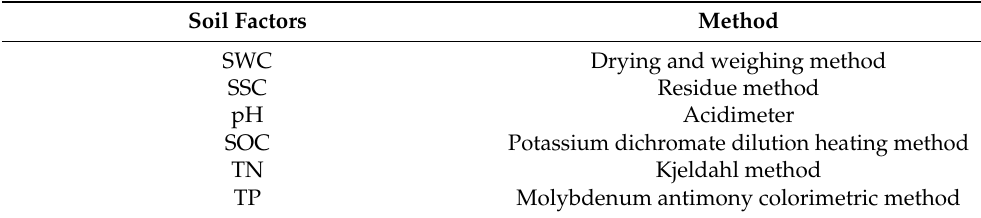
Table 1. Soil index and determination method.